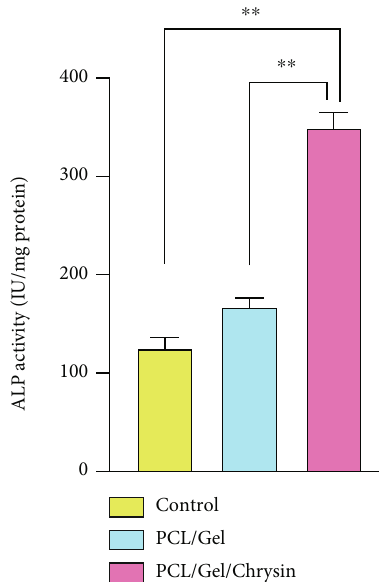
Figure 8: ALP enzyme activities after DPSCs were seeded on PCL/CS and PCL/CS/CH sca ff olds after 7 days. Cells cultured without sca ff old are considered control. Data reported as the mean ± SD performed in triplicate. The PCL/Gel/CH group showed signi fi cantly higher ALP activity compared to other groups ( ∗∗ p < 0 : 01 ).